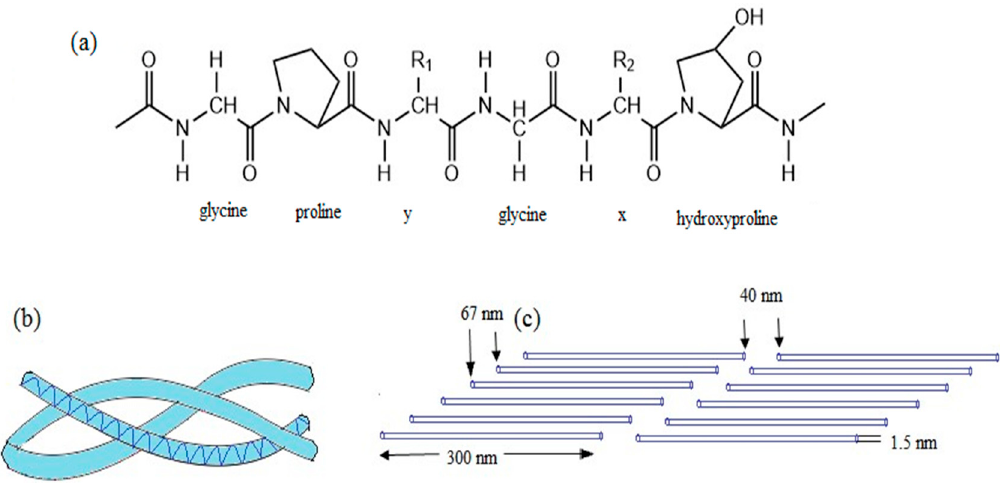
Figure 4. Chemical structure of collagen type I ( a ) Primary amino acid sequence; ( b ) secondary left handed helix and tertiary right handed triple-helix; ( c ) staggered quaternary structure.